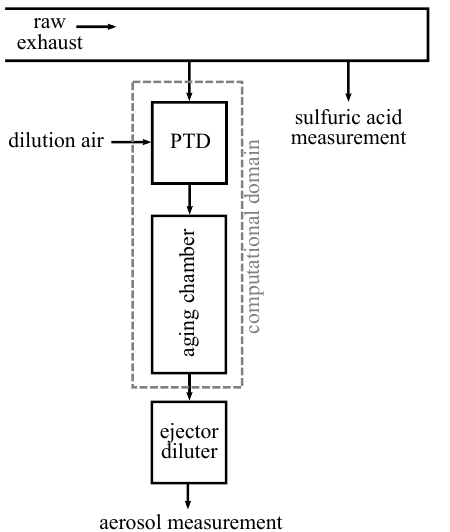
Figure 3. The part of the measurement setup relevant for the simu- lations. The computational domain consists of a PTD and an aging chamber only due to an approximation that the ejector diluter has a minor effect only on the particle distribution.